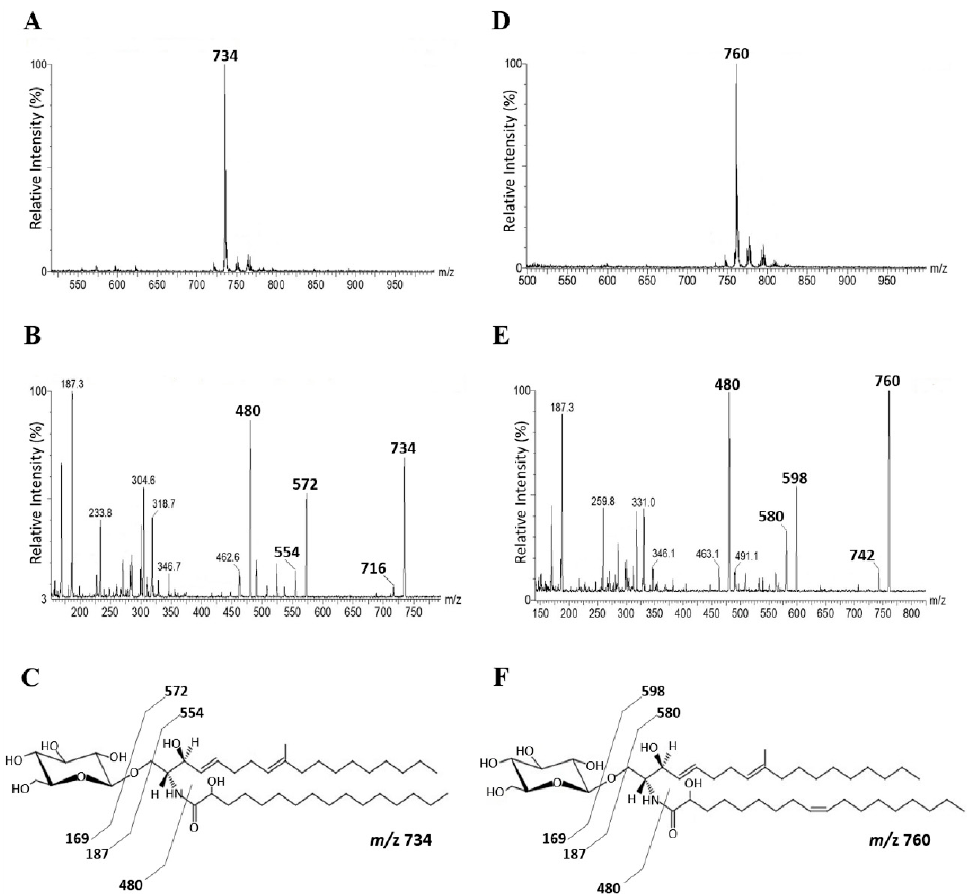
Figure 1. Positive ESI-MS (electrospray ionization mass spectrometer) [M + Li] analysis of GlcCer (Glucosylceramide) species from P. minutispora and S. aurantiacum . ESI-MS1 of GlcCer species from P. minutispora ( A ) and S. aurantiacum ( B ). ESI-MS2 of the major ion species m / z 760 ( C ) and m / z 734 ( D ). Proposed structures for P. minutispora GlcCer species ( E ) and S. aurantiacum GlcCer species ( F ).